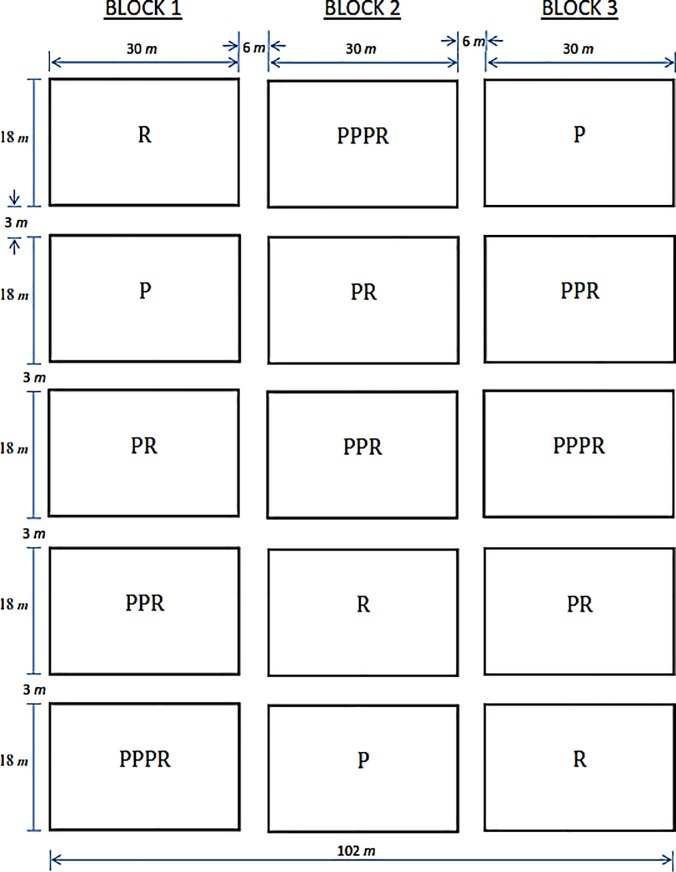
Field layout showing the randomization of the treatments.